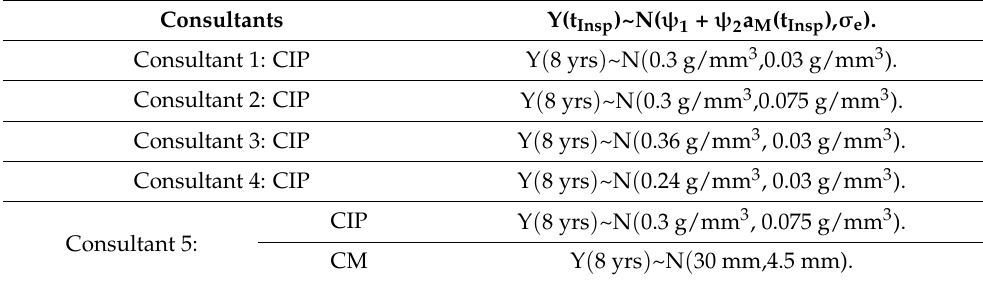
Table 8. Likelihood functions obtained based on assumed inspection values and consultants’ accuracy.